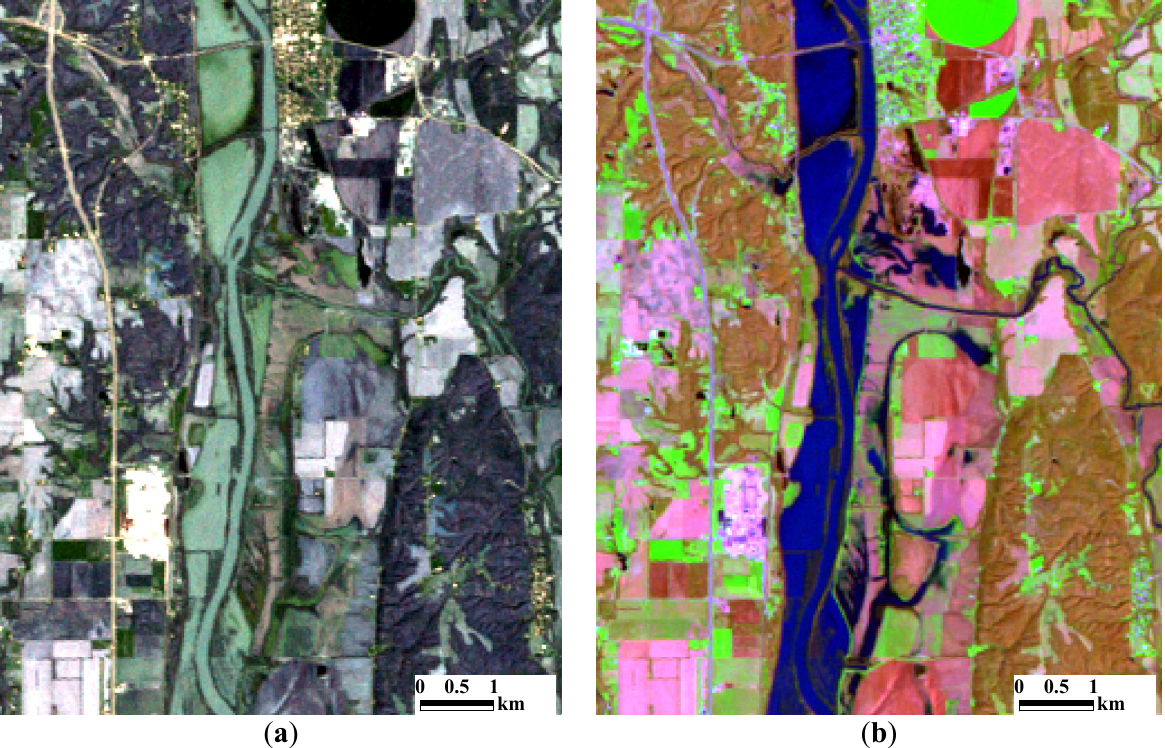
Figure 3. Comparison of the band combinations in the Montezuma reach (11 April